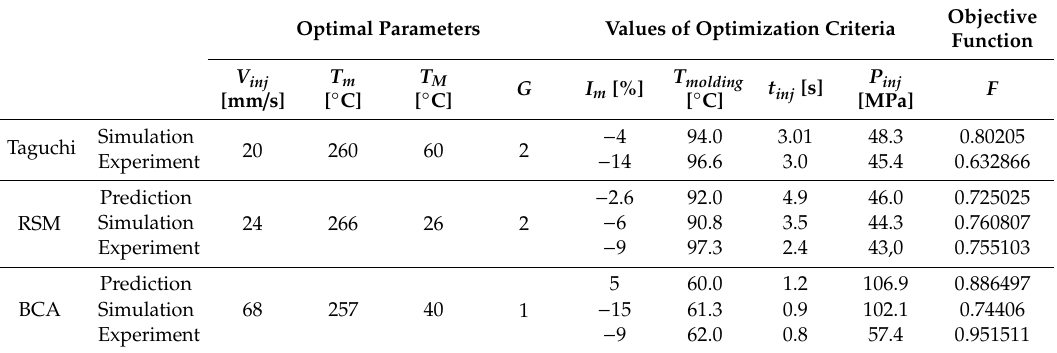
Table 5. Results of optimization.